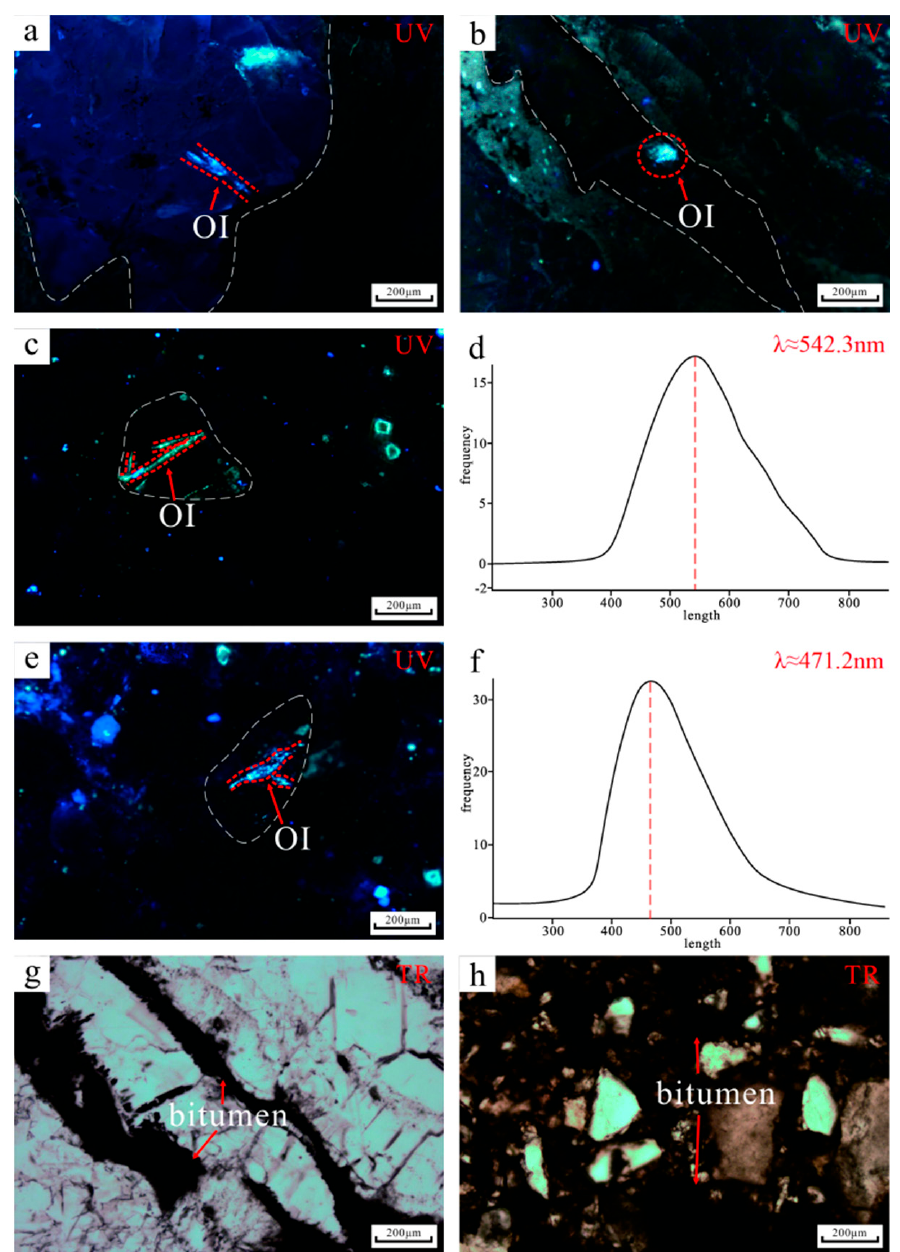
Figure 7. Micrographs of oil inclusions and reservoir bitumen of the Qingshuiying Formation in Well YQ-1. ( a ) At 3749.96 m, oil inclusions in a calcite grain; ( b ) at 3749.96 m, oil inclusions in a calcite grain; ( c ) at 3749.96 m, layered black and dark brown reservoir bitumen; ( d ) at 4248.45 m, block black and dark brown reservoir bitumen; ( e ) at 4248.5 m, oil inclusions in crackles of a quartz grain; ( f ) the fluorescence spectroscopy of ( e ); ( g ) at 4249.9 m, oil inclusions in cracks of a quartz grain; ( h ) the fluorescence spectroscopy of ( g ).